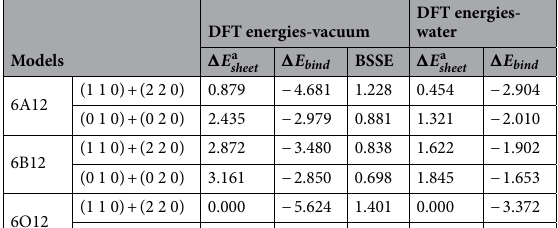
Table 3. DFT energies of the B3LYP-D3BJ optimized 3 × cello-tetramer chain sheet models (kcal·mol −1 per residue). a Relative to the plane of (1 1 0) by 6A12